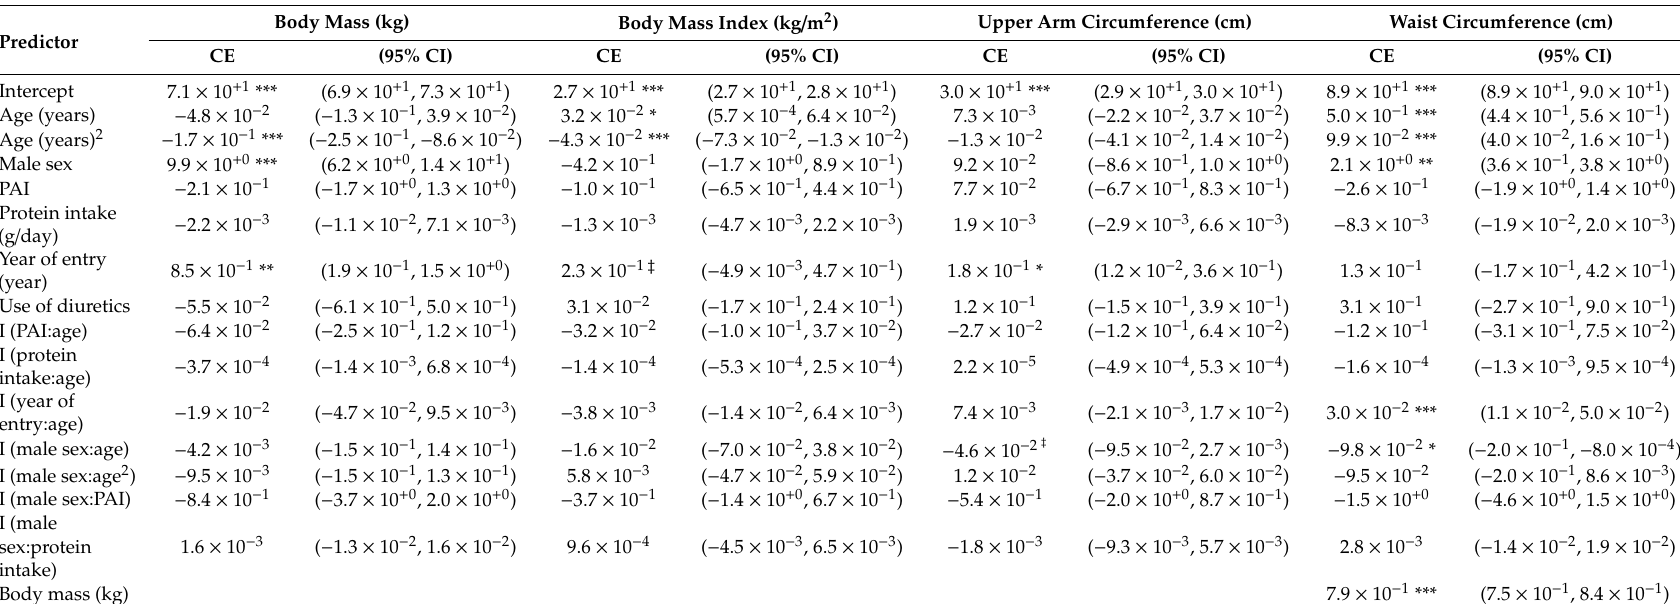
Table 3. Predictors in linear mixed-e ff ects models for anthropometric data ( n =